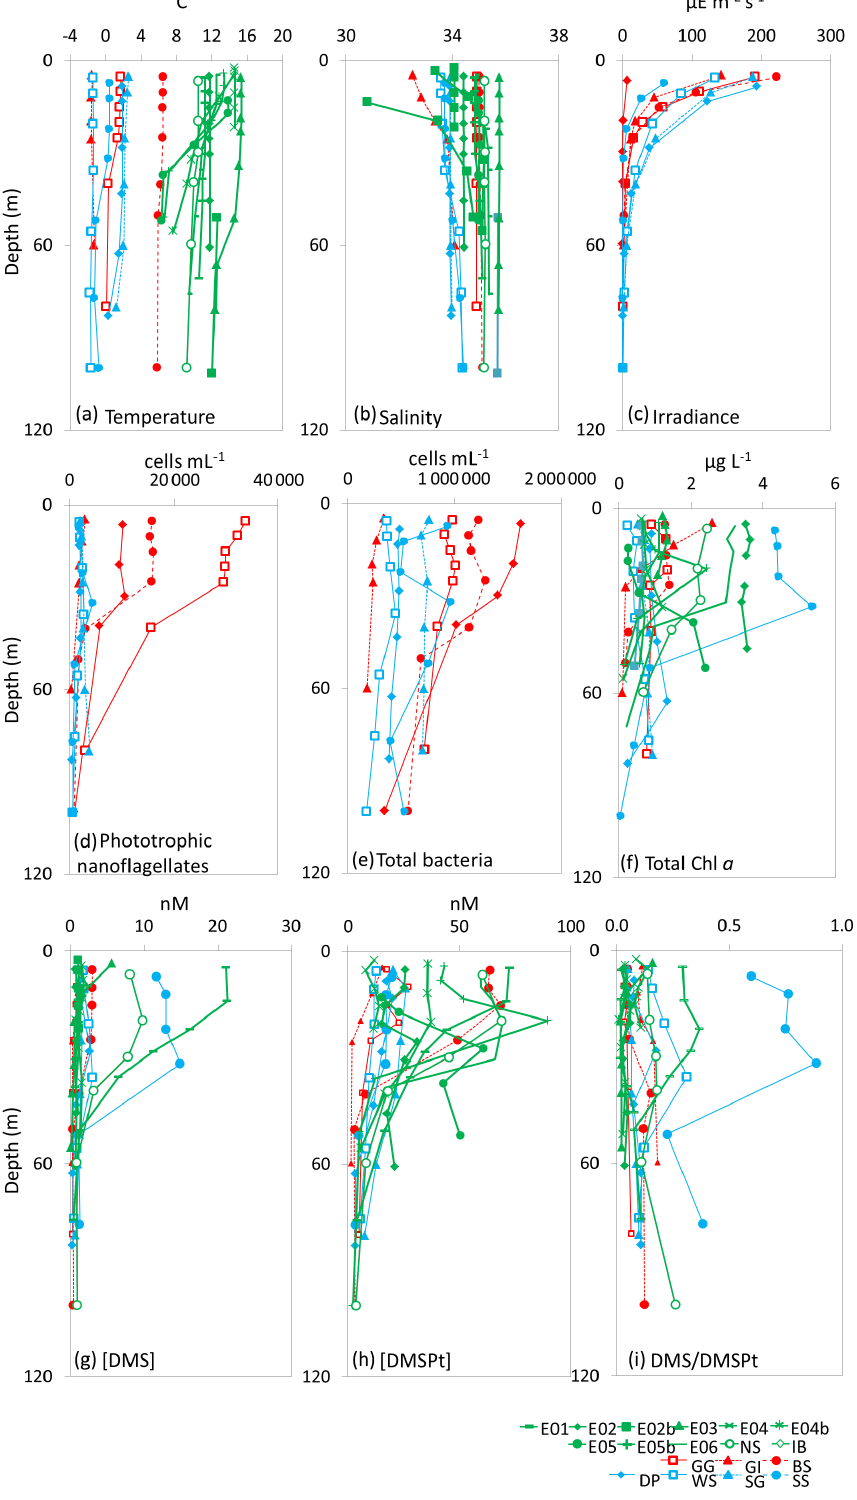
Figure 2. Depth profiles down to 100m depth for all 18 sampling stations showing (a) temperature ( ◦ C), (b) salinity, (c) irradiance (µEm − 2 s − 1 ), (d) phototrophic nanoflagellate abundance (cellsmL − 1 ), (e) total bacteria abundance (cellsmL − 1 ), (f) total Chl a (µgL − 1 ), (g) [DMS] (nM), (h) total [DMSP] (nM) and (i) DMS/DMSPt from CTD casts at sampling stations for microcosm experiments in temperate (green), Arctic (red) and Southern Ocean (blue) waters. See Table 1 for station details. Data for irradiance, phototrophic nanoflagellates and total bacteria were not collected for temperate